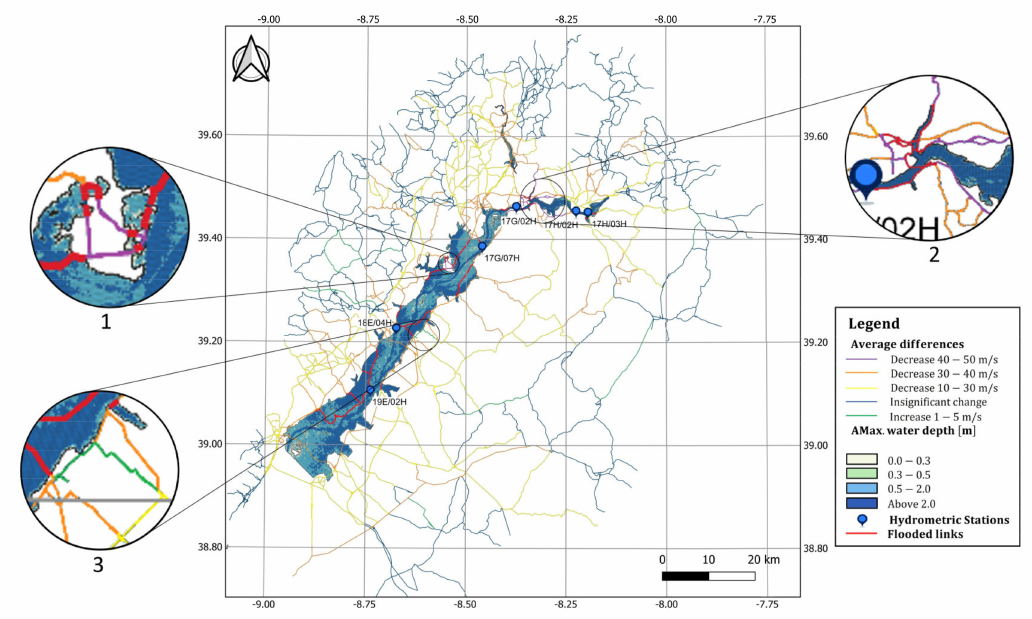
Figure 7. Speed differences between flooded and normal conditions during a